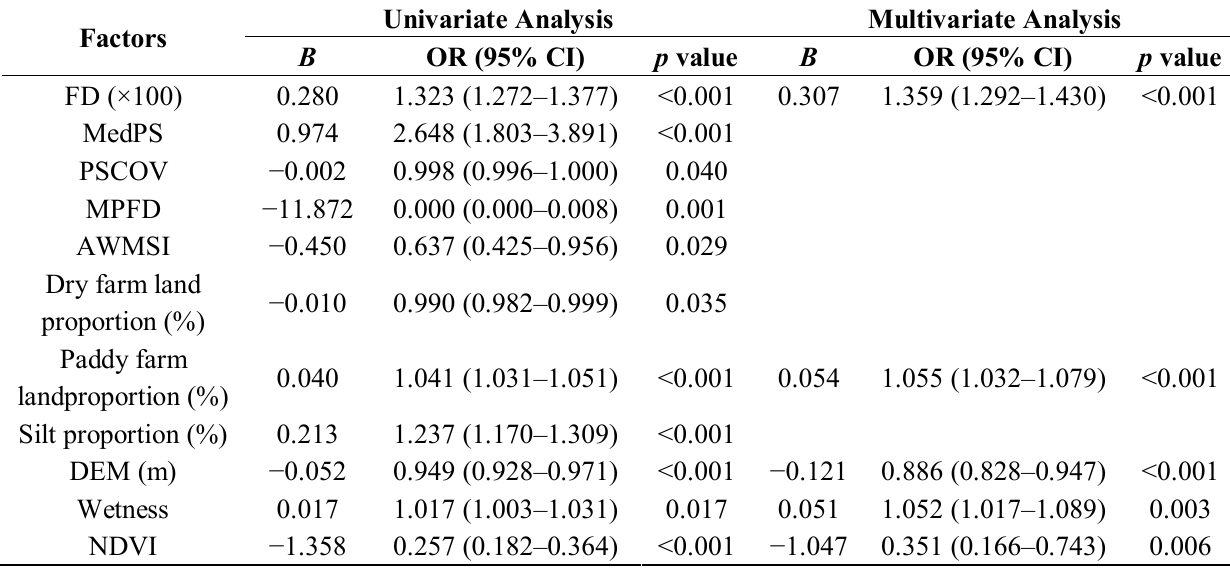
Table 1. Results of the logistic regression models applied to snail habitats.